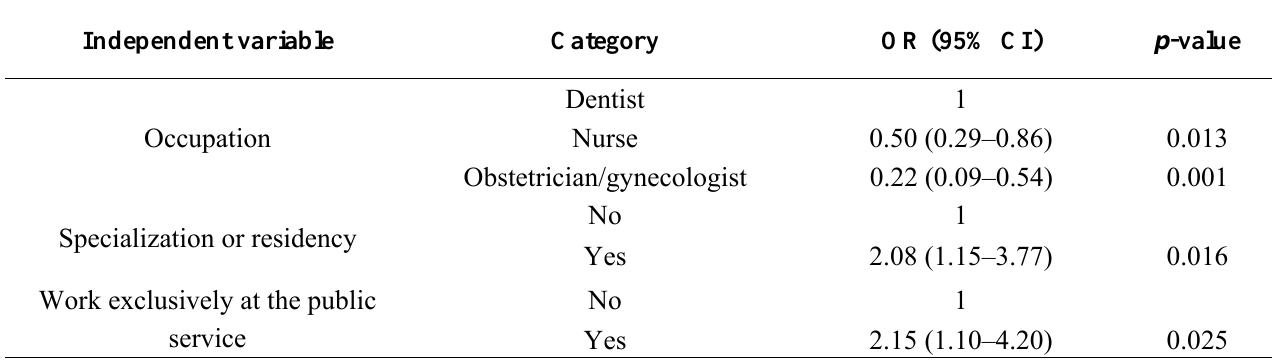
Table 3. Final multiple logistic regression model for the independent variables explaining more favorable attitudes towards oral health of pregnant